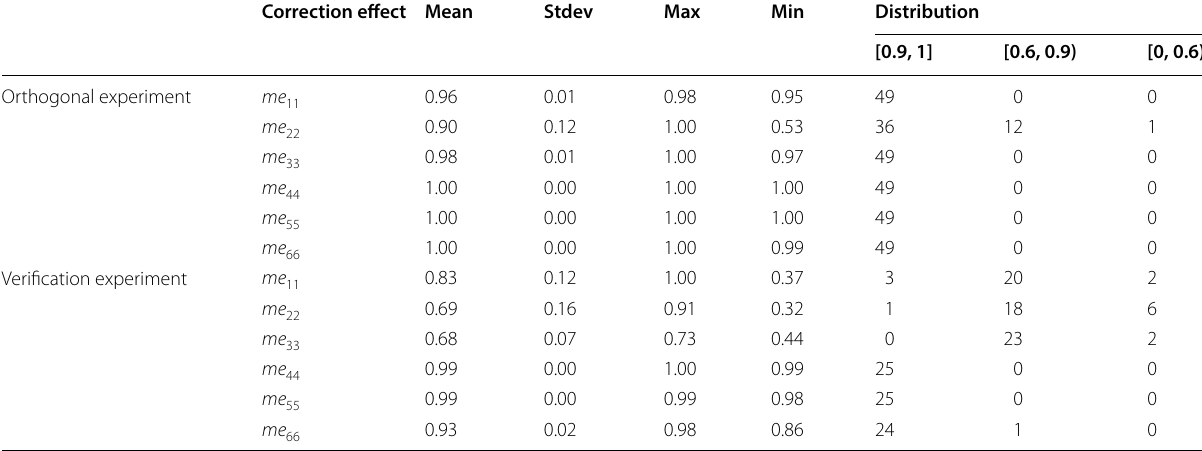
of correction coefficient c ii